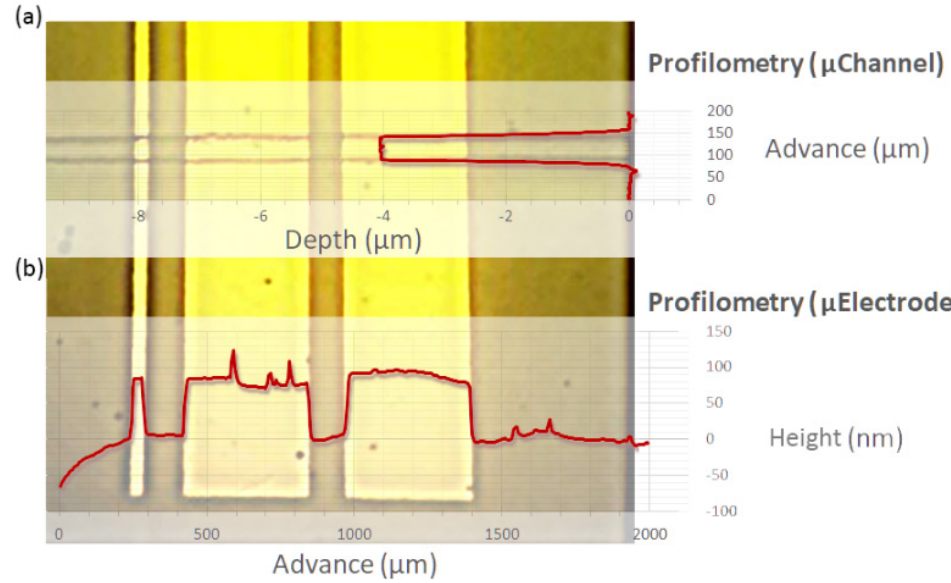
Figure 4. Micrograph of the microsystem active area with ( a ) representative profilometry of the microchannel structure and ( b ) representative profilometry of microelectrodes.